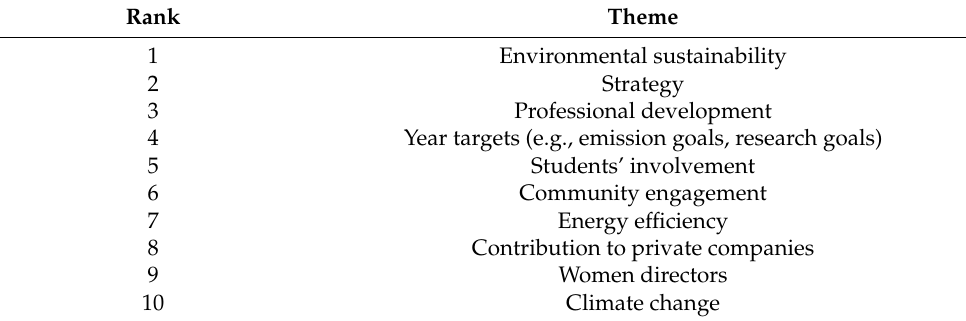
Table 4. Top 10 SDGs—related